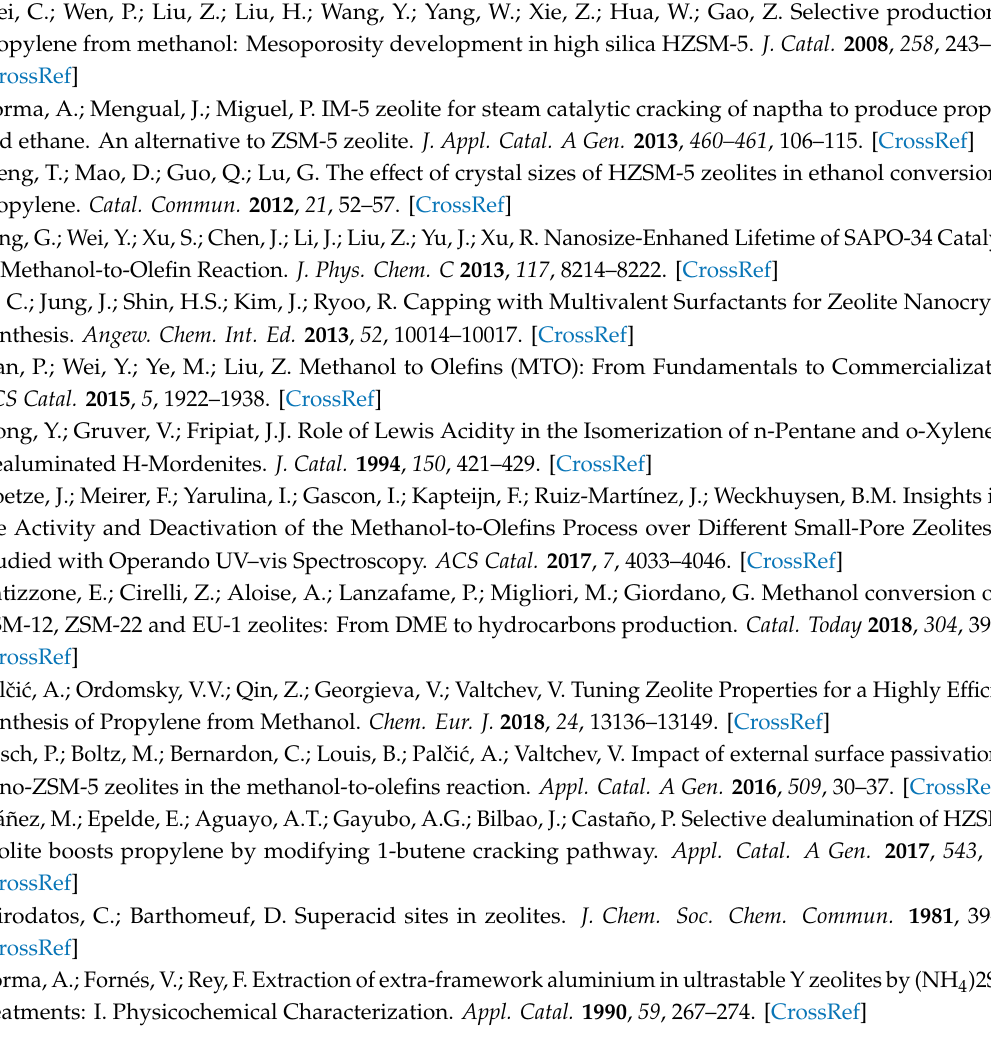
catalysts. Table S1: Quantification data obtained from FT-IR spectra after CO adsorption (9.9 mbar